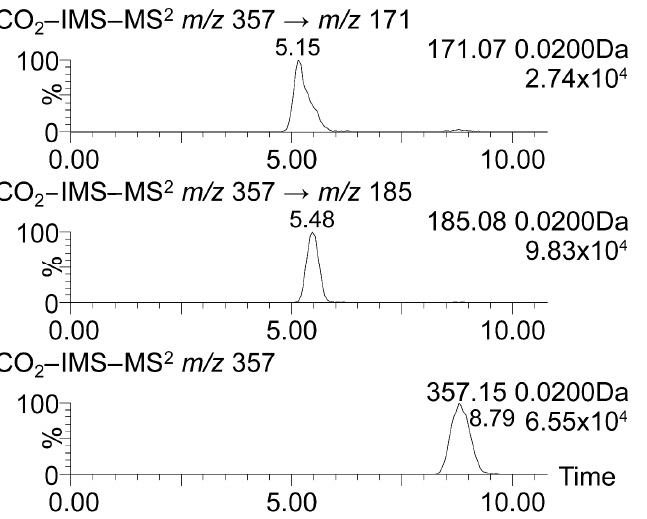
Figure 6 Figure 6. CO 2 - driftgrams of precursor and major product ions originating from the m / z 357 ion. The top panel shows m / z 171 (C 8 H 11 O 4- ), the middle panel shows m / z 185 (C 9 H 13 O 4- ), and the bottom panel shows m / z 357 (C 17 H 25 O 8- ). The time axis is in